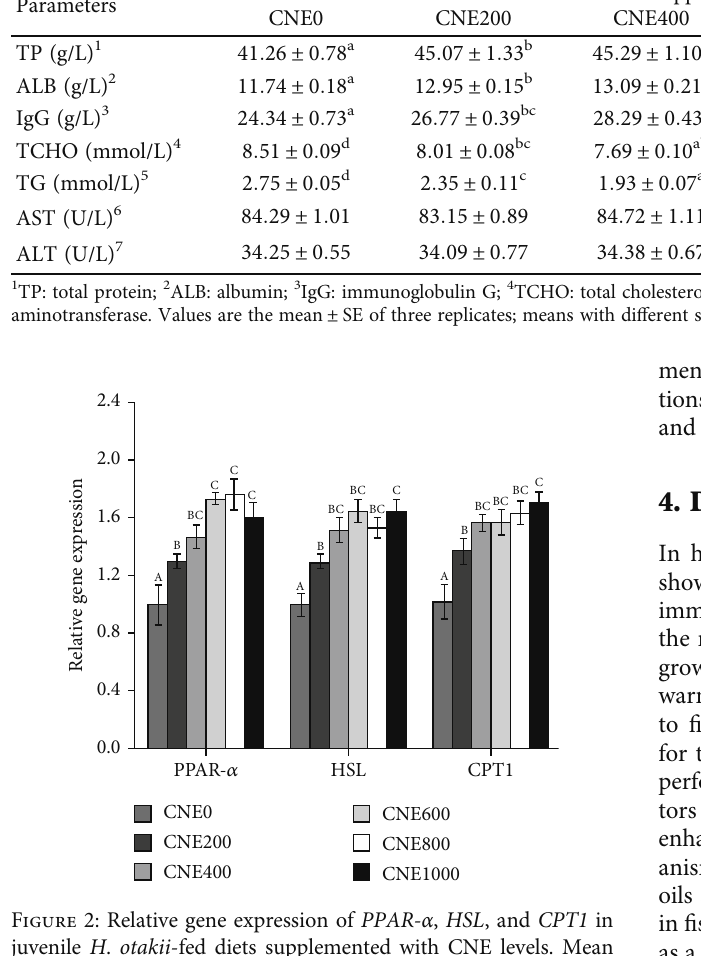
aminotransferase; 7 ALT: alanine aminotransferase. Values are mean ± SE of three replicates; means with di ff erent subscripts are signi fi cantly di ff erent ( P < 0 : 05 ). Table 8: Serum biochemistry of juvenile H. otakii fed the experimental diets for 8 weeks. Parameters